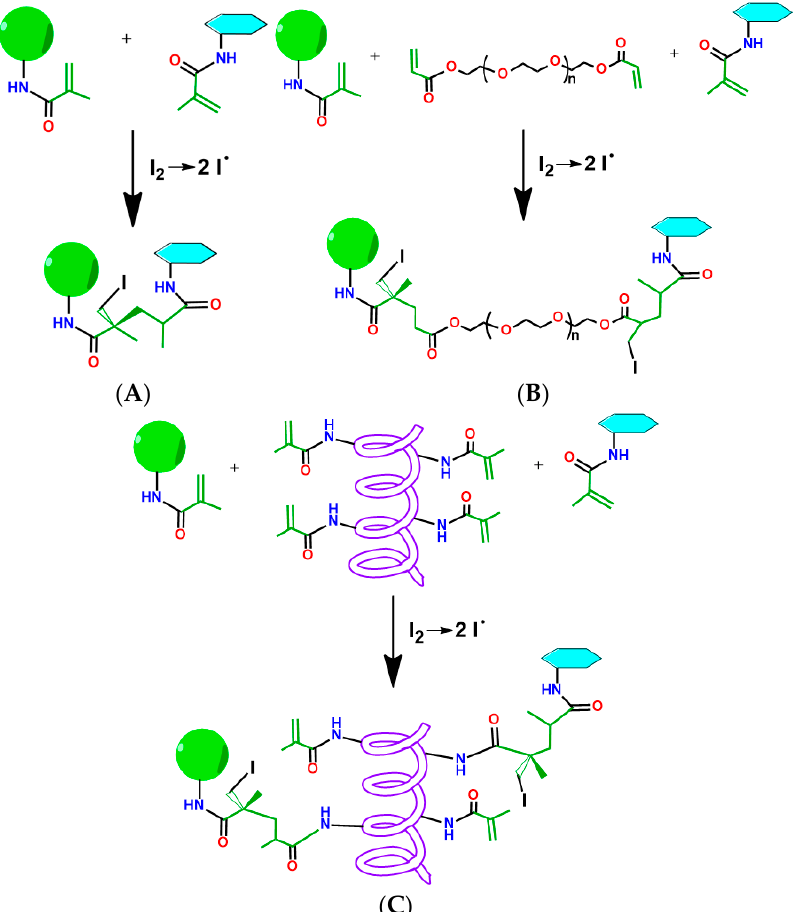
Figure 7. The possible schemes of particle cross-linking: ( A ) direct methacrylated particle cross-linking; ( B ) particle cross-linking with application of PEGDA as cross-linking agent; ( C ) particle cross-linking with application of GelMA as cross-linking agent.